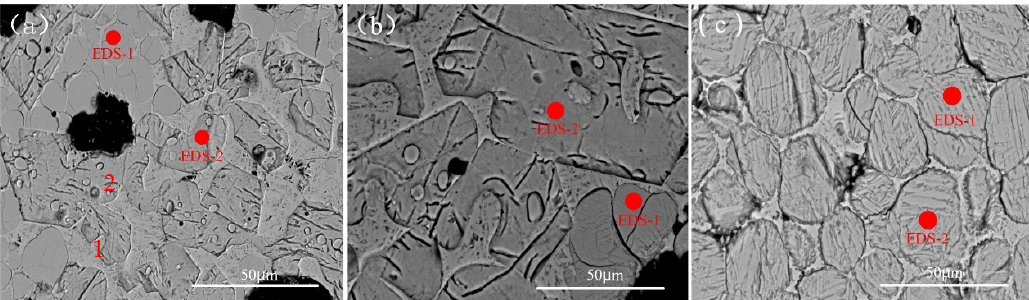
Figure 5. SEM spectrum of Cr-doped cement clinker. ( a ) with 0.8% Cr; ( b ) with 1.0% Cr; ( c ) with 5.0% Cr. Table 5. EDS analysis of Cr-doped clinker microregion.